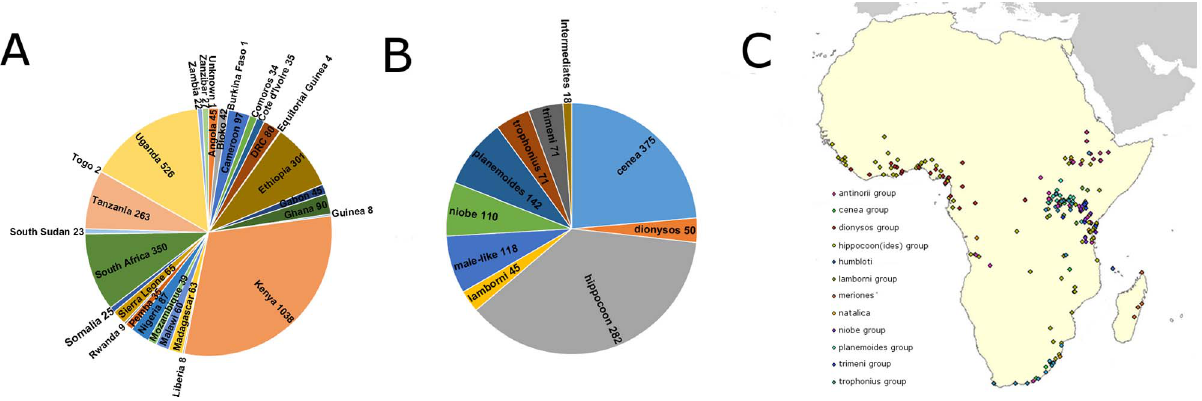
Figure 4. Summary of pinned Papiliodardanus preserved by the NHM London. A) Pie chart showing breakdown of NHM London P. dardanus collection by country. The islands of Pemba, Zanzibar and Bioko are considered separately from the African mainland. B) Pie chart showing contribution of each morph group among the 1575 female specimens in the collection. Not shown are the 1817 male specimens. The ‘intermediate’ class contains specimens with attributes of more than one morph group, making classification impossible. C) Distribution of point locality data across Africa, labelled by wing pattern.